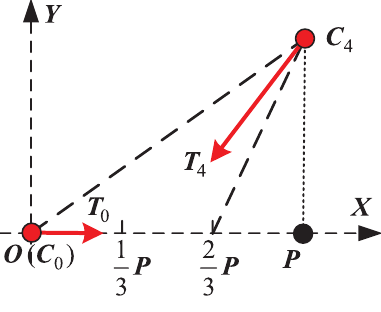
Fig. 8 Given data to interpolate.